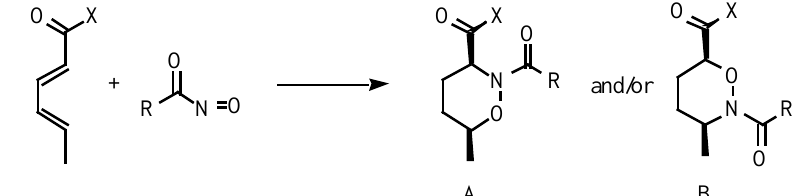
Figure 1: Two possible regiomers in the addition of an acylnitroso group to a